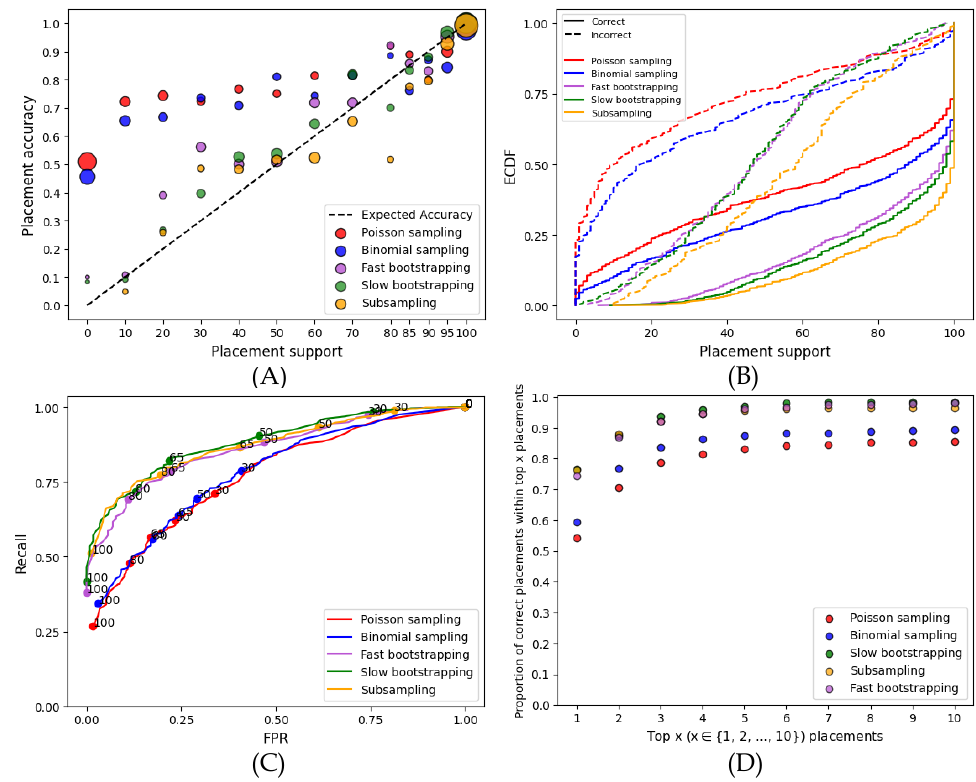
Figure 1. Results for the RNAsim single-gene dataset. ( A ) Support versus the percentage of correctly placed queries. Support values are binned at left-inclusive intervals on the x -axis; the last bin only includes 100%. The unity line shows fully calibrated support. Dot sizes are proportional to the number of queries in each bin. The MSE computed with respect to the unity line divided between support ≤ 70% and > 70% are as follows: low support—0.21 for Poisson, 0.17 for Binomial, 0.018 for Fast BS, 0.007 for slow BS, and 0.006 for subsampling; high support—0.003 for Poisson, 0.004 for Binomial, 0.001 for Fast BS, 0.0008 for slow BS, and 0.005 for subsampling. ( B ) Empirical cumulative distribution function (ECDF) of the support for correct/incorrect placements. ( C ) Receiver operating characteristic (ROC) curves using a range of 0–100 of support thresholds. Selected thresholds are marked. ( D ) The frequency of the correct placement being among the top 1 ≤ x ≤ 10 highest support